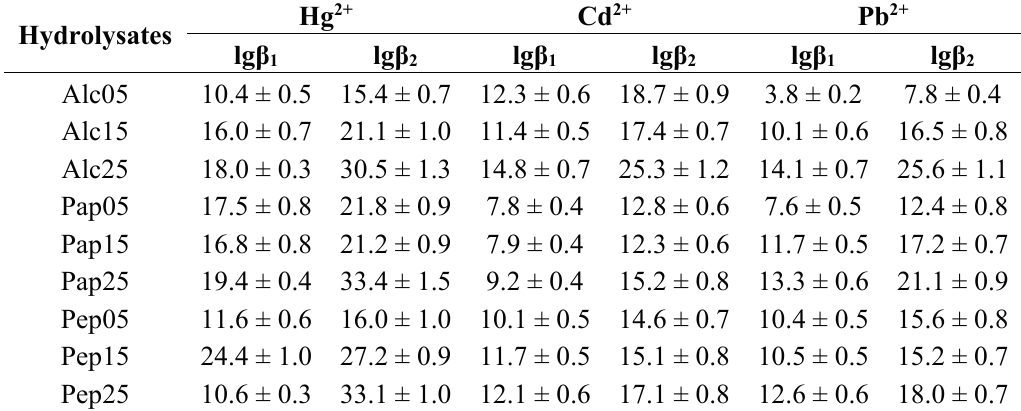
Table 4. Stability constants between TCPs and Hg 2+ , Cd 2+ and Pb 2+ at 25 °C, I = 0.1 M KCl α .